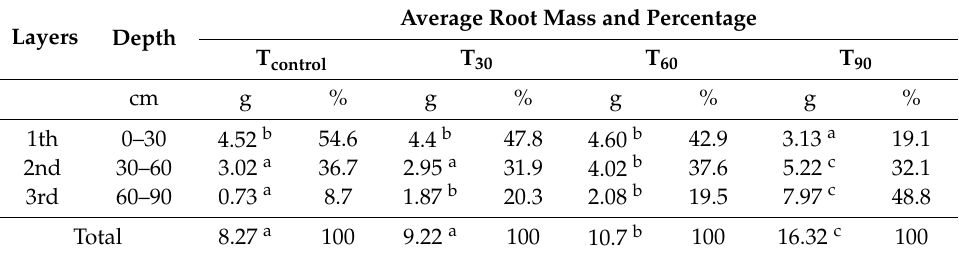
Table 6. Average root mass and proportions of roots.